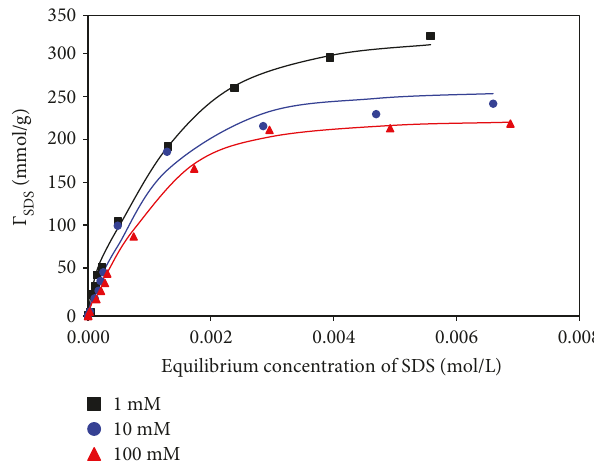
O in di ff erent Figure 6: Adsorption isotherms of STS onto Al 2 3 NaCl concentrations. While the points are experimental data, the solid lines are the results of the 2-step adsorption